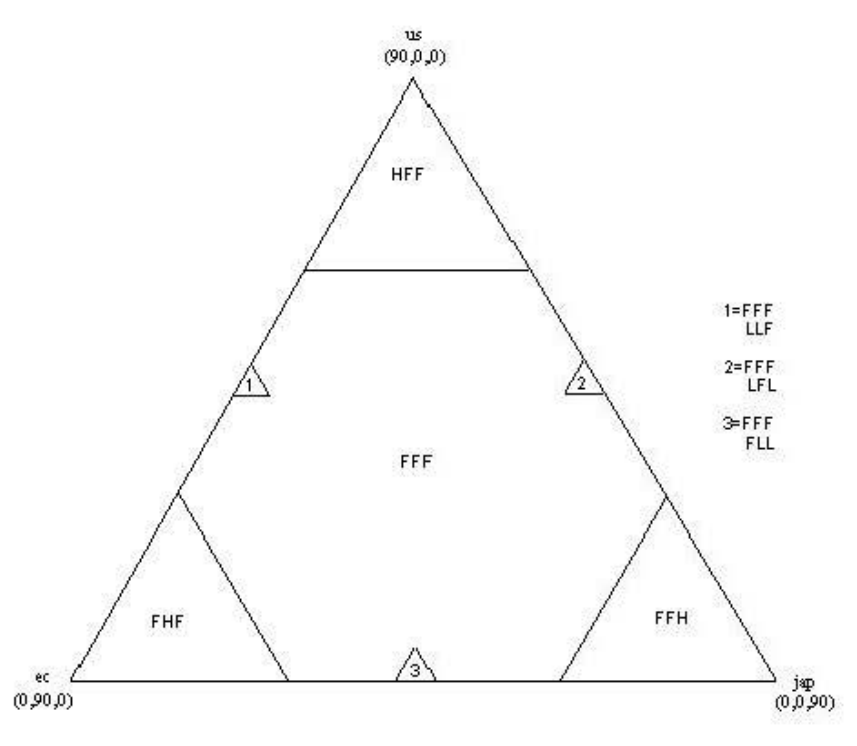
Fig. i.3 Eq11i!ibri11m dum1"1erizatitmf()I'